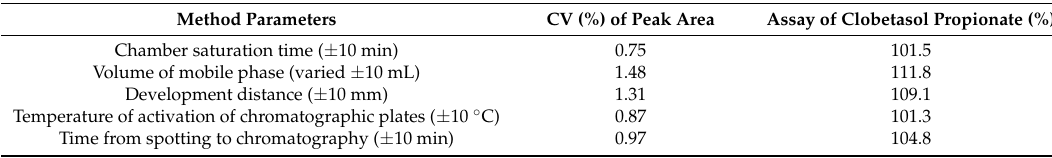
Table 5. Robustness of proposed TLC-densitometric method ( n = 3).